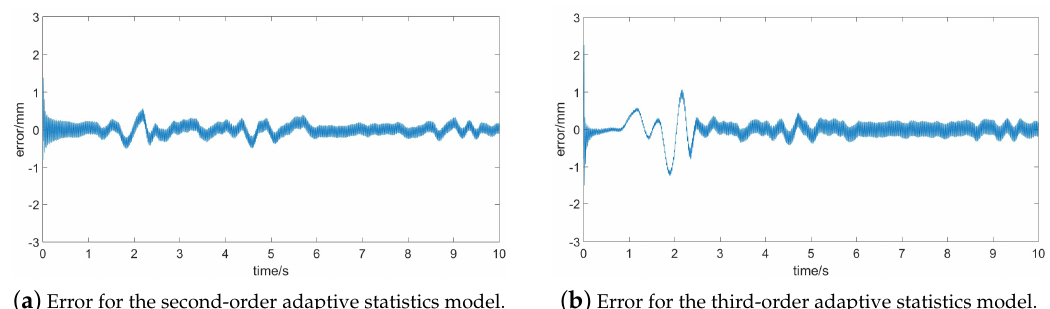
Figure 4. The denoised result of the adaptive statistics models.